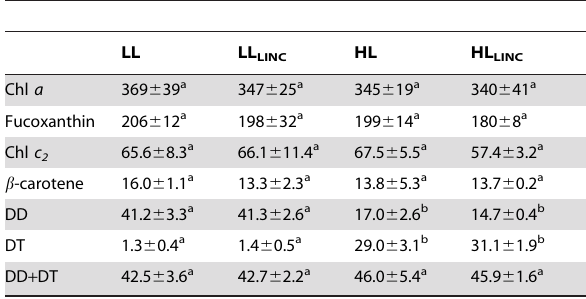
Table 1. Pigment concentrations (fg cell 2 1 ) in Phaeodactylum tricornutum